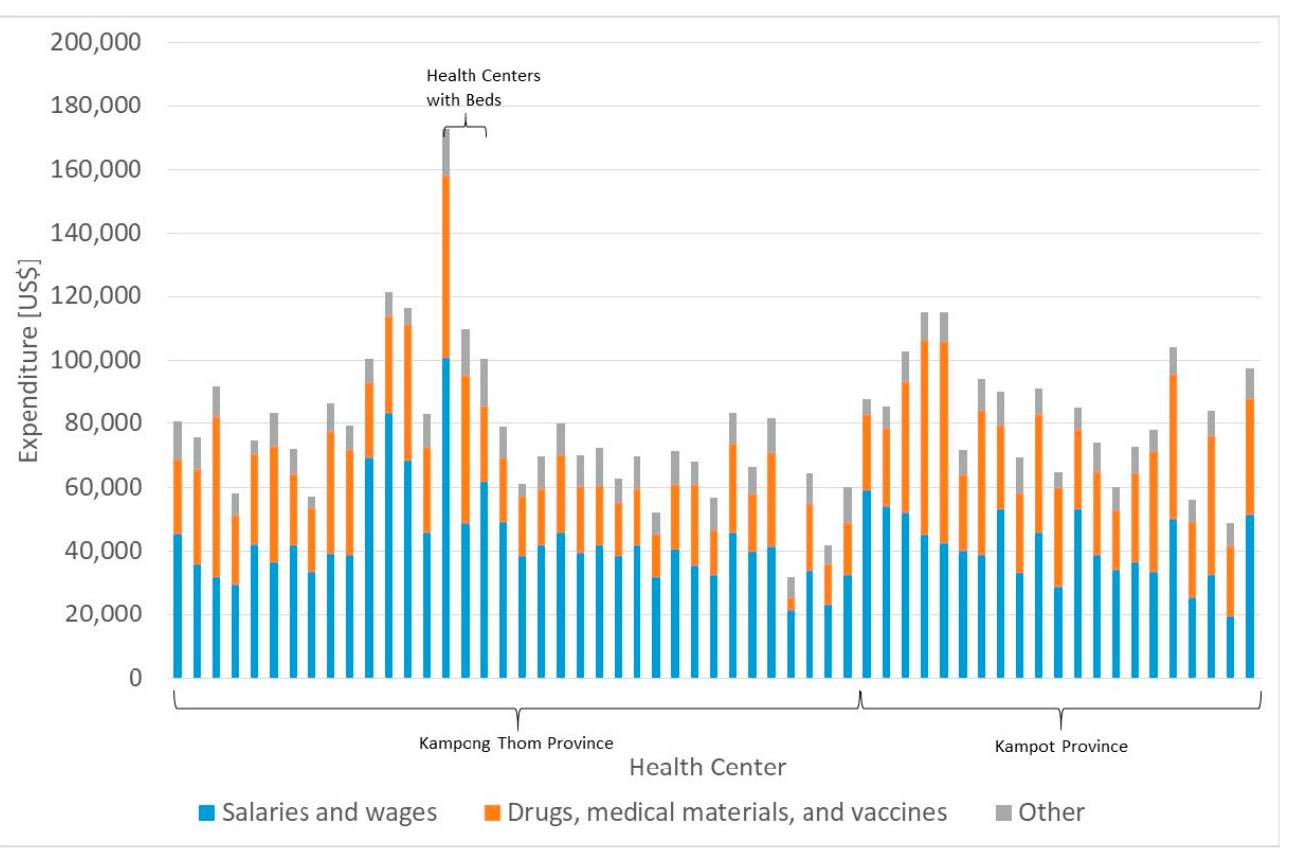
Figure 4. Expenditure categories. Source: own.